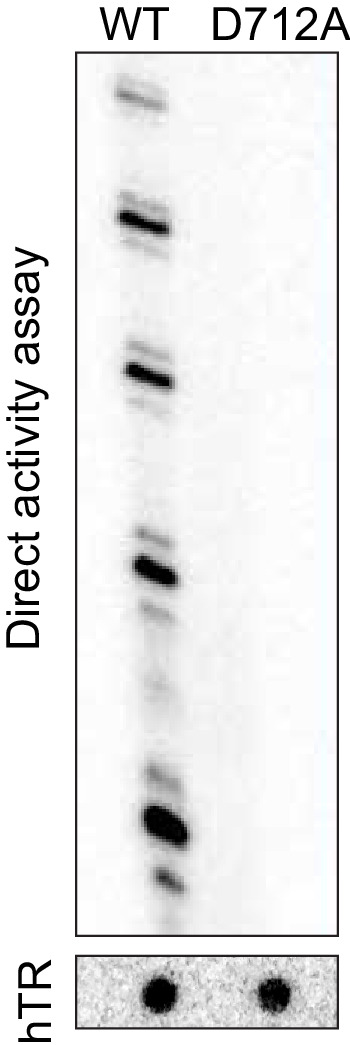
Telomerase activity assay using purified catalytically inactive human telomerase (D712A) compared with wild type (WT) telomerase.Upper gel shows products of telomerase extension of oligonucleotide Bio-L-18GGG (1 µM; Supplementary file 1); lower panel shows a northern blot of the amount of hTR in each telomerase preparation, to control for equal amounts of enzyme.